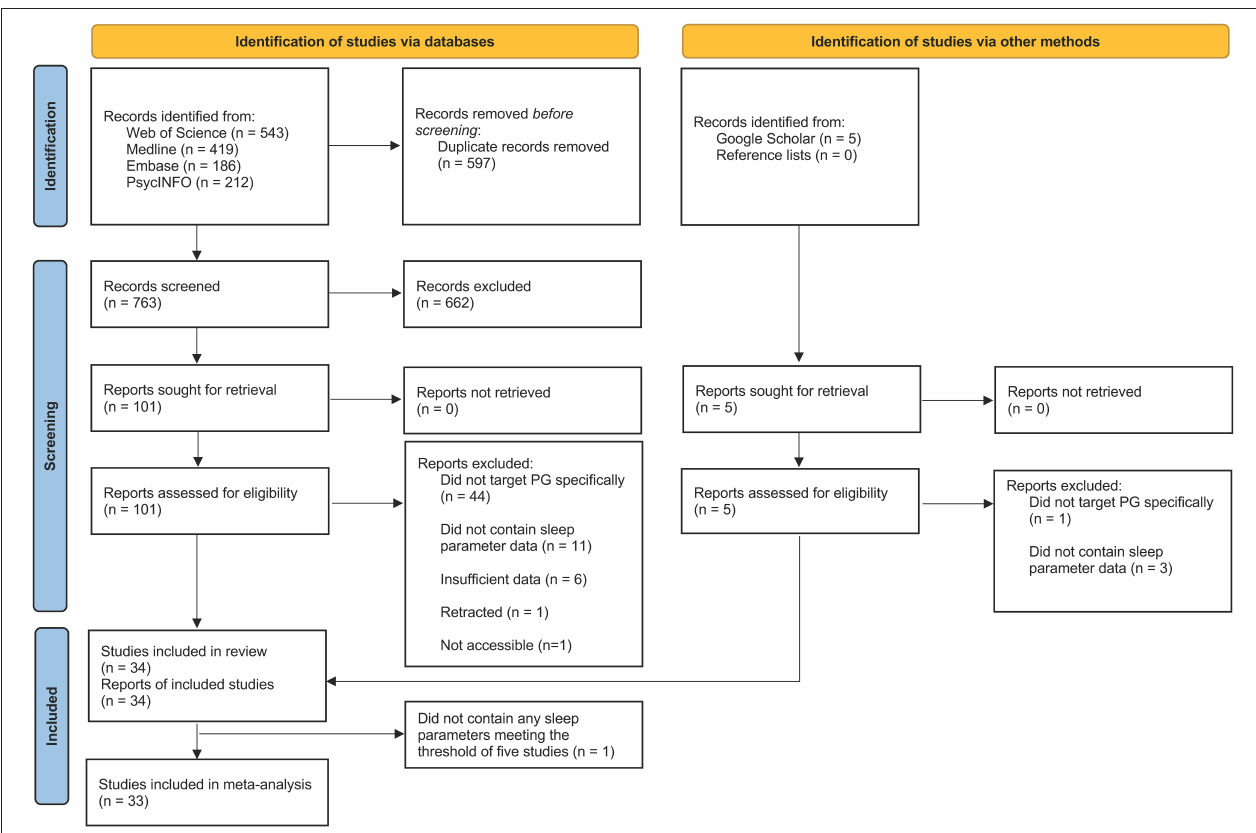
FIGURE 1 | PRISMA 2020 flow diagram of the study screening and selection